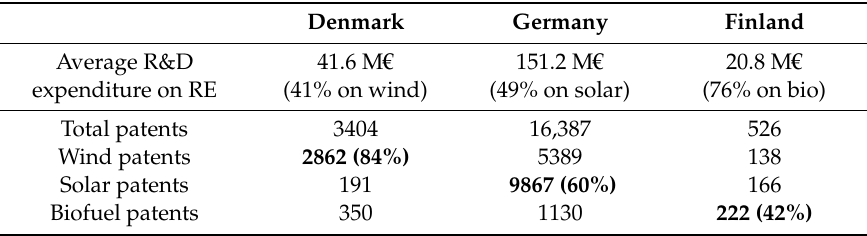
Table 1. Sticky R&D e ff orts and results: The amount of RE technology patents (wind, solar, and biofuels) in the case study countries between 1990 and 2016 and the average state direct R&D expenditures [21,22]. As the bolded numbers show, the analyzed countries have concentrated particularly on certain technologies in their R&D e ff orts—and this has also paid dividends in most